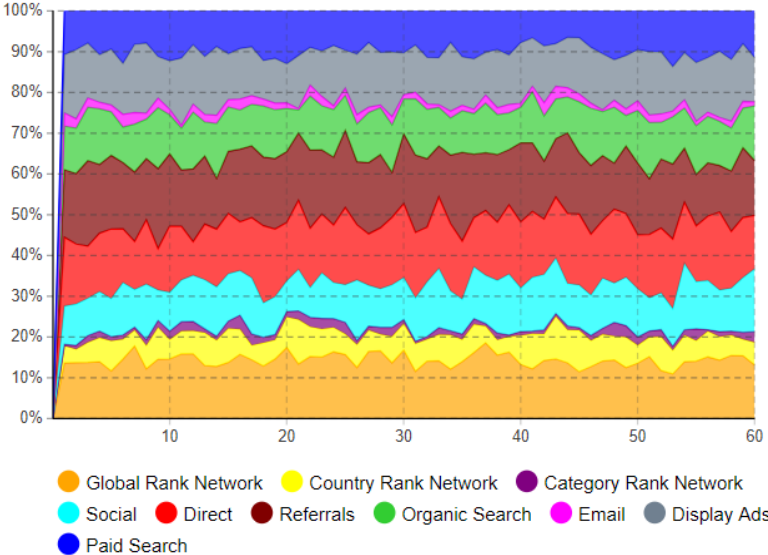
Figure 4. Expanded time stack chart showing the values received by the parameters (GlobalRankNetwork, CountryRankNetwork, CategoryRankNetwork, Direct, Social, Referrals, OrganicSearch, Email, DisplayAds and PaidSearch) over the 60 day measurement period.